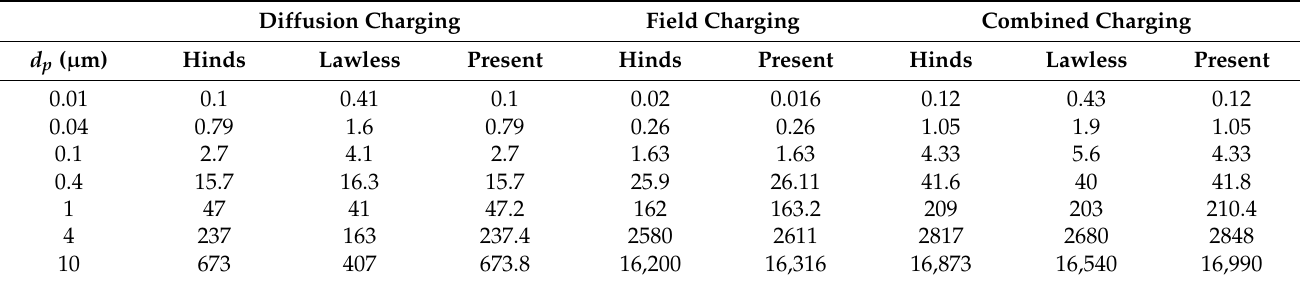
Table 1. Comparison of particle charging at N i t = 10 13 (s/m 3 ), ε p = 5.1, E ave = 500 (kV/m).